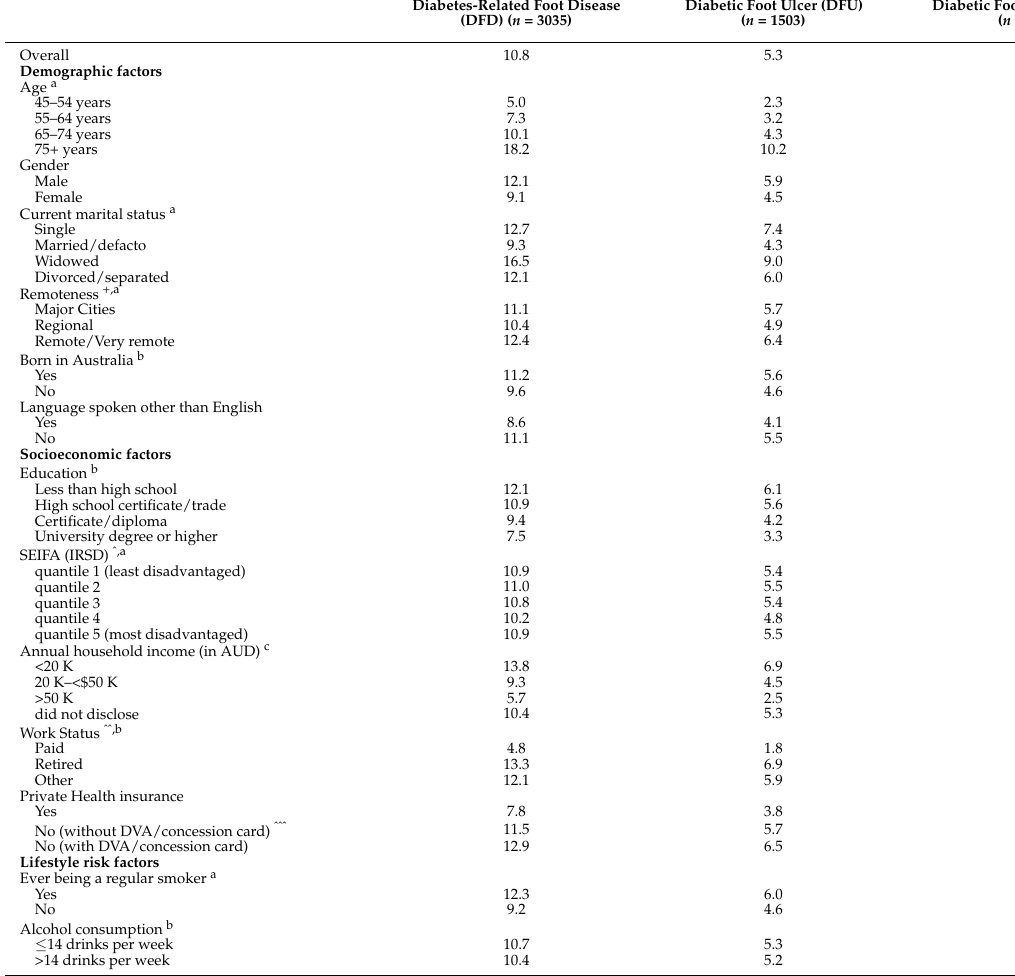
DiabeticFootInfection(DFI) ( n =1448) DiabeticGangrene(DG)( n =123)